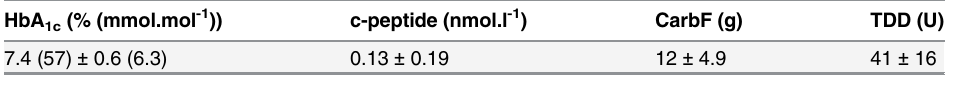
Table 2. Diabetes specific characteristics: HbA 1c : hemoglobin A 1c ; c-peptide: connecting peptide; CarbF: carbohydrate factor; TDD: total daily dose of insulin. Values are given as mean and SD.